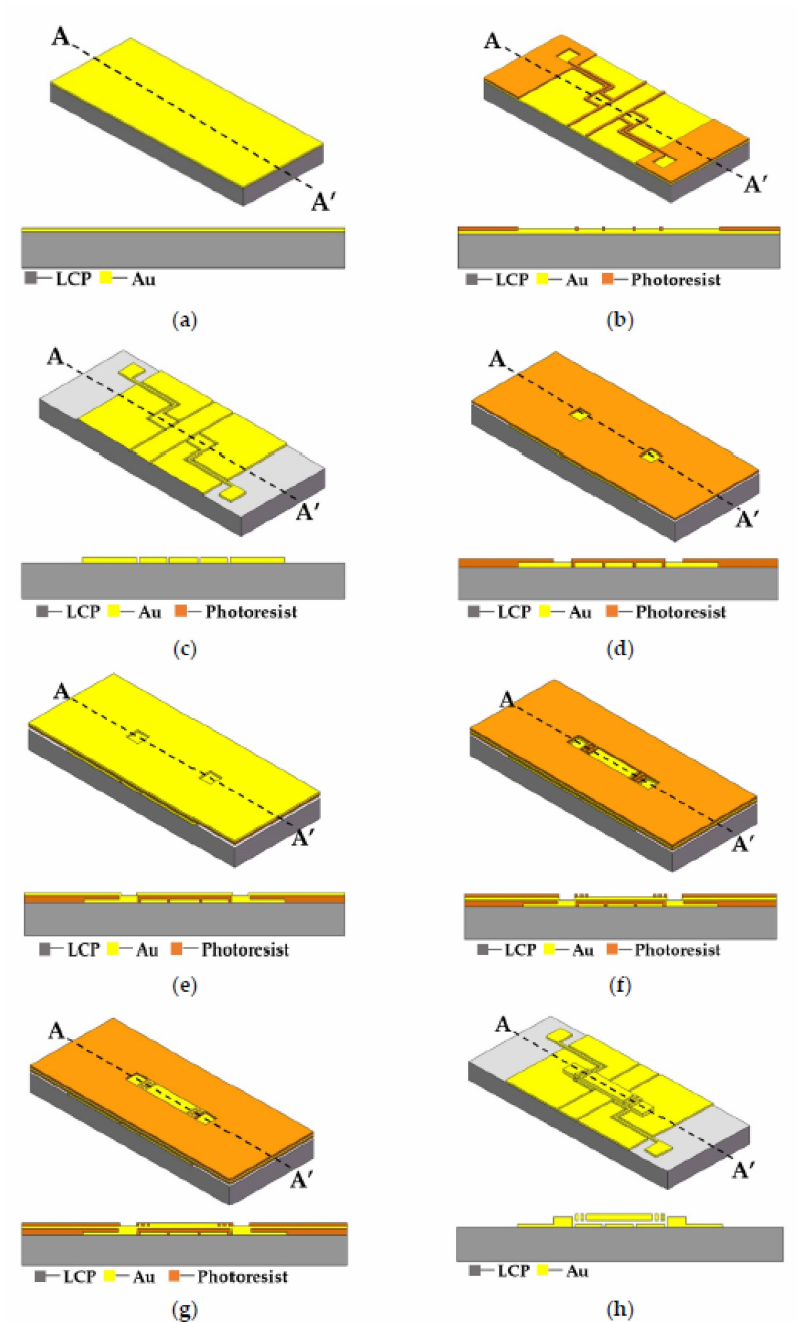
Figure 10. Surface processing technology based on flexible LCP substrate [67]. ( a ) Sputter the CPW seed layer; ( b ) Pattern the seed layer and electroplate; ( c ) Remove the redundant seed layer; ( d ) Pattern the anchor photoresist; ( e ) Sputter the beam seed layer; ( f ) Pattern the beam photoresist; ( g ) Electroplate the beam; ( h ) Release the